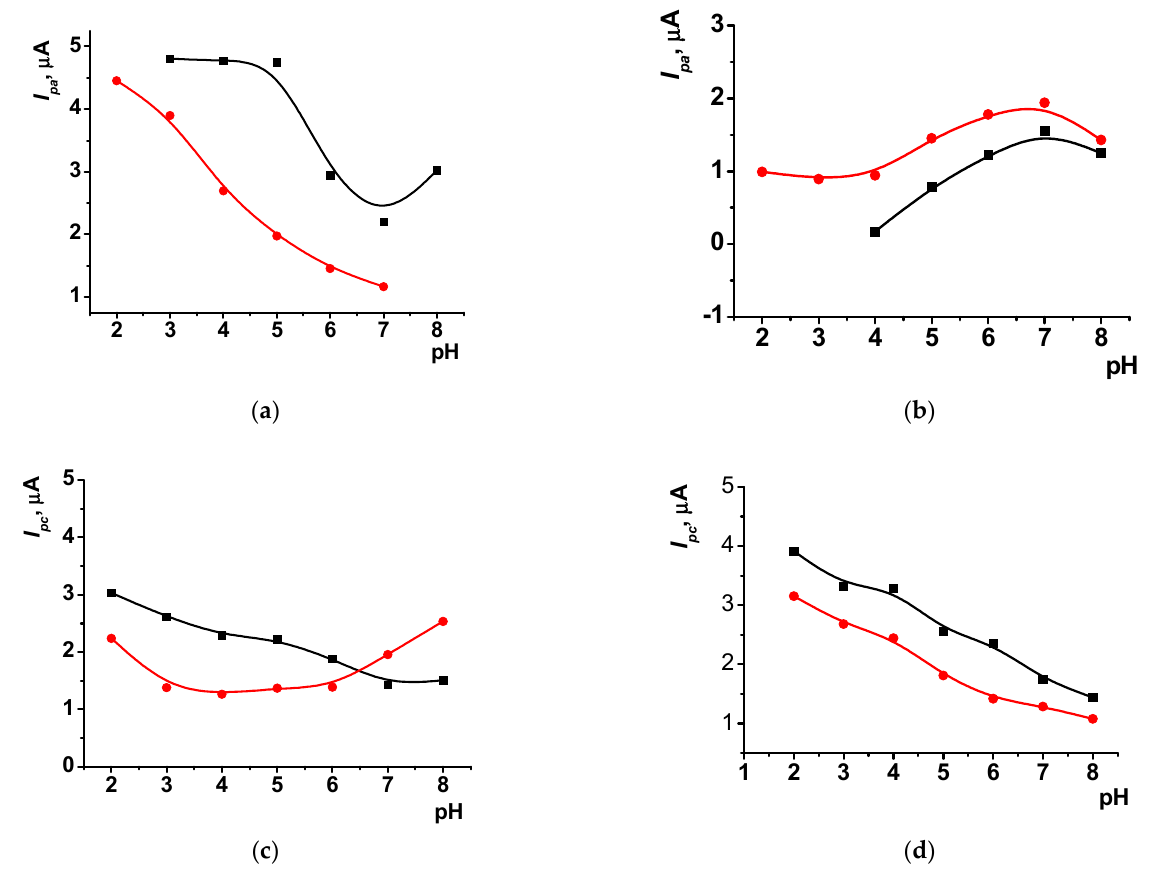
Figure 4. The pH dependence of the anodic peak current of the monomer ( a ) and polymer ( b ), cathodic peak current of the monomer ( c ) and polymer ( d ) for PAB-1 (black) and PAB-2 (red) layers, Britton–Robinson buffer, pH 2–8.